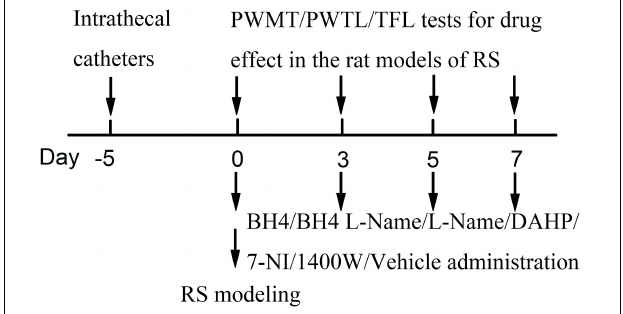
FIGURE 8 | Experimental design. RS, restraint stress; PWMT, paw withdrawal mechanical threshold; PWTL, paw withdrawal thermal latency; TFL, tail-flick latency; BH4, tetrahydrobiopterin; L -NAME, N ω -nitro- L -arginine methyl ester; DAHP, 2,4-diamino-6-hydroxypyrimidine; 7-NI, 7-nitro indazole; 1400W, N